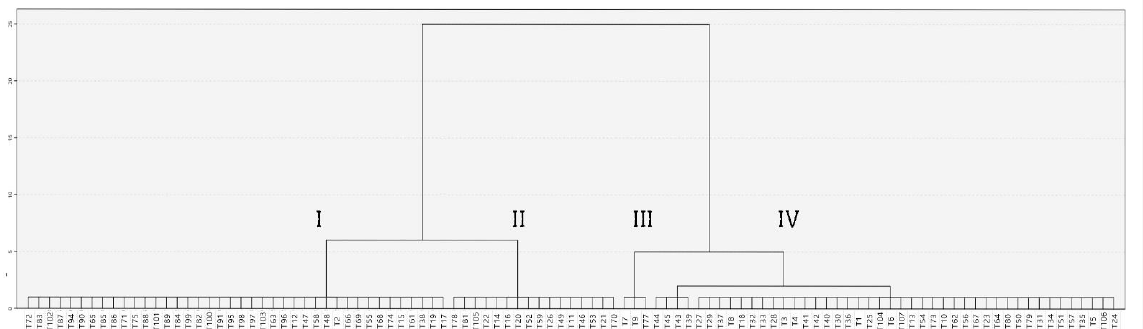
Figure 3. Dendrogram obtained by cluster analysis according to the chemical components of essen- tial oils in 103 Korean native T. quinquecostatus individuals. oils in 103 Korean native T. quinquecostatus